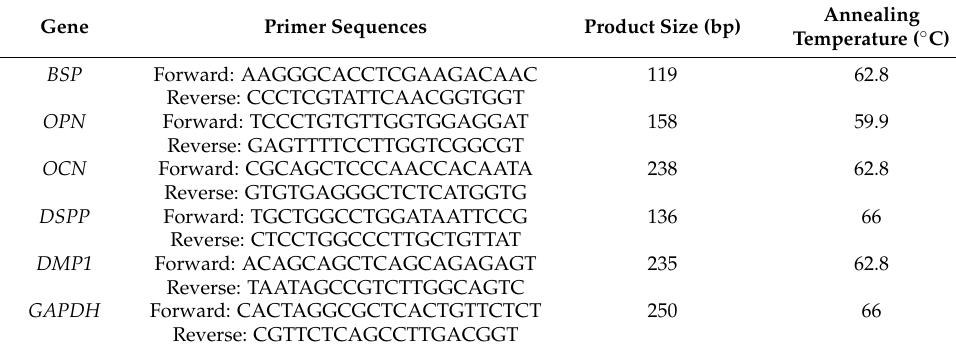
Table 2. Primer sets used for real-time